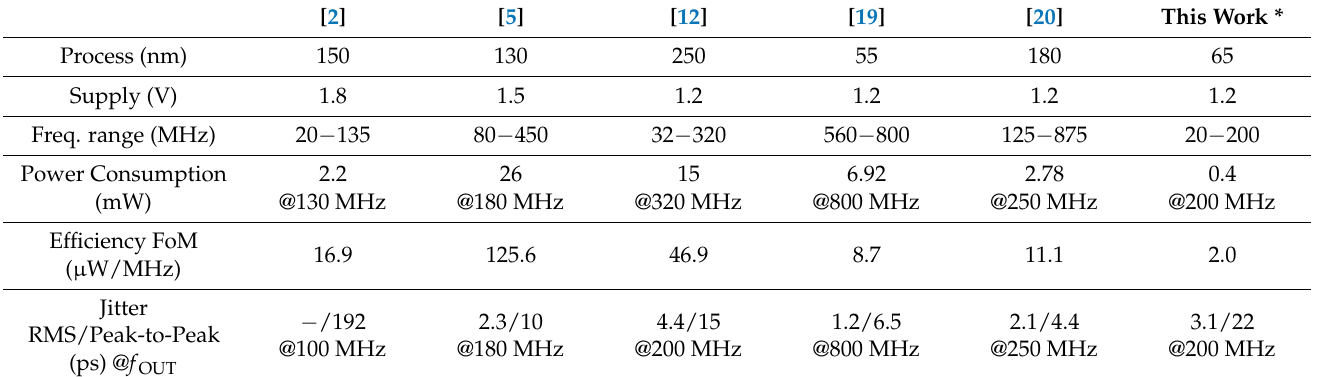
Figure 11. Jitter simulation at 200 MHz: ( a ) overlapped waveforms of 256 cycles; ( b ) histogram of 2500 samples. Table 2. Performance Summary of the proposed PD-MDV DLL.